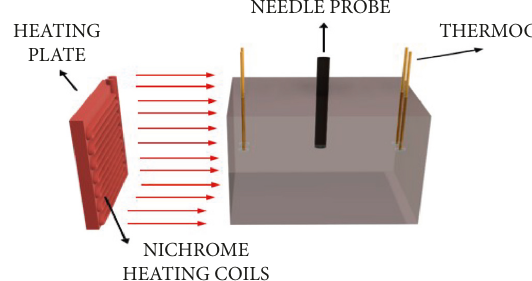
Figure 3: Thermal molding method: one-dimensional heat flow.